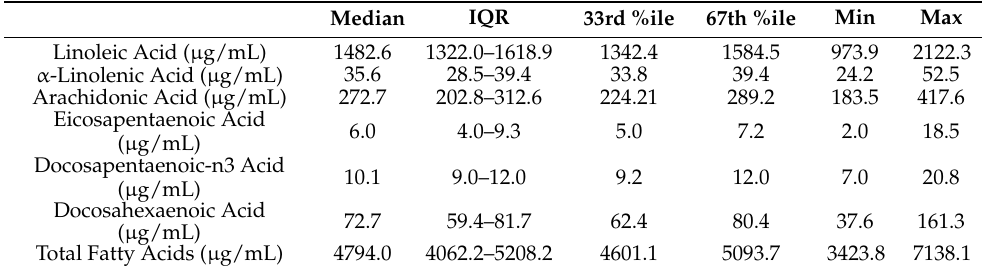
Table 2. Concentrations of PUFAs in Maternal Plasma.